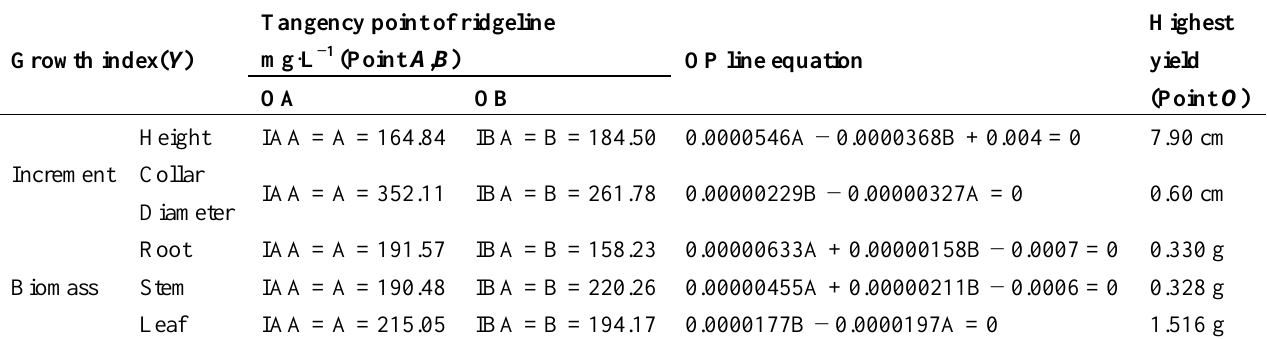
Table 5. Tangency points of yield-equality lines graph and op-curve equations of growth in response to IAA and